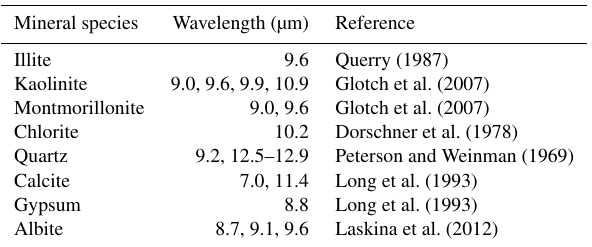
Table 3. Position of LW absorption band peaks (6–15µm) for the main minerals composing dust. Montmorillonite is taken here as representative for the smectite family. For feldspars literature data are available only for